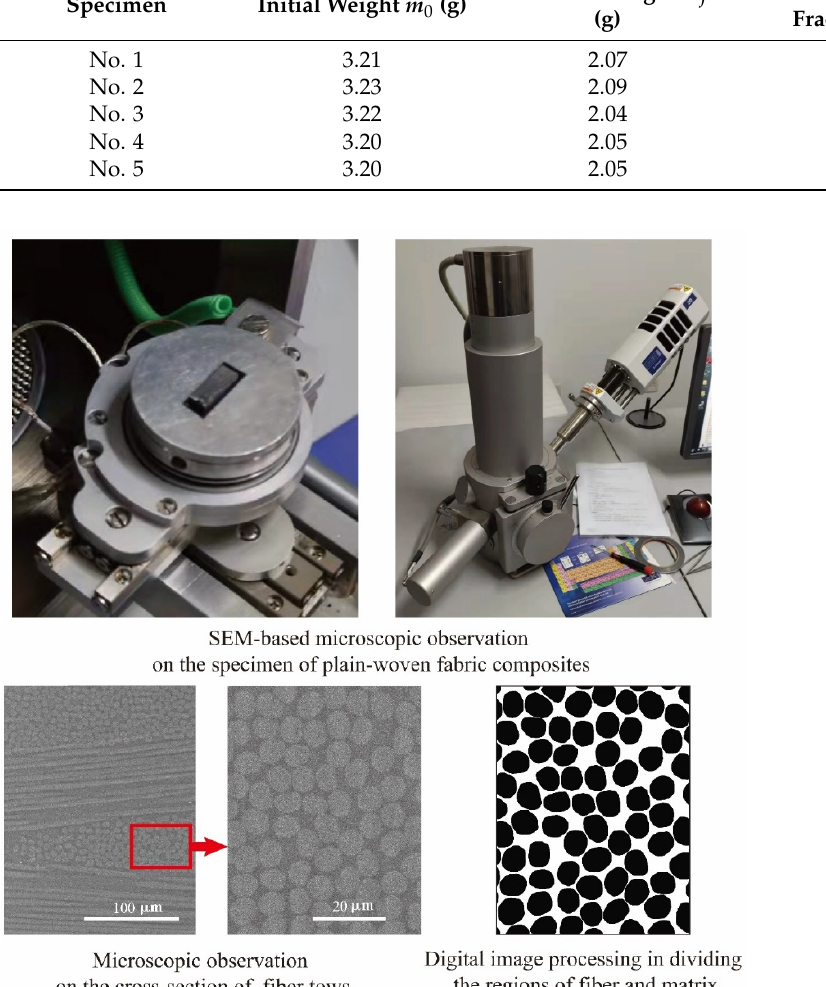
Figure 11. Microscopic observation of the specimen of plain-woven fabric composites and digital image processing for the SEM observation result.